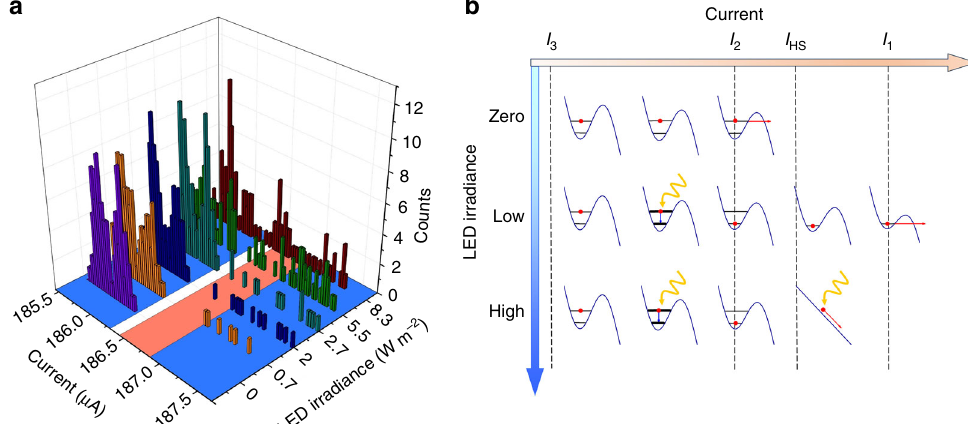
Fig. 5 Switching-current measurements for the nanowire illuminated by optical radiation with 460 nm wavelength. a SCDs of a 55-nm-wide YBCO nanowire measured at 5.4 K for different LED irradiances. Regions I and II (blue) correspond to ground and exited energy states of the nanowire. Region III (red) is the current region, in which switching can only occur by the hotspot effect. Source data are provided as a Source Data fi le. b Illustration of the interaction of optical photons with the YBCO nanowire. The populated energy level is shown by a red dot. Photon absorption and escape events are indicated by wavy yellow and red arrows, respectively. Collapse of the order parameter after photon absorption is shown by an inclined blue line. The currents I 1 , I 2 , and I 3 are the same as in Fig. 4e. The current I HS indicates the boundary of the hotspot